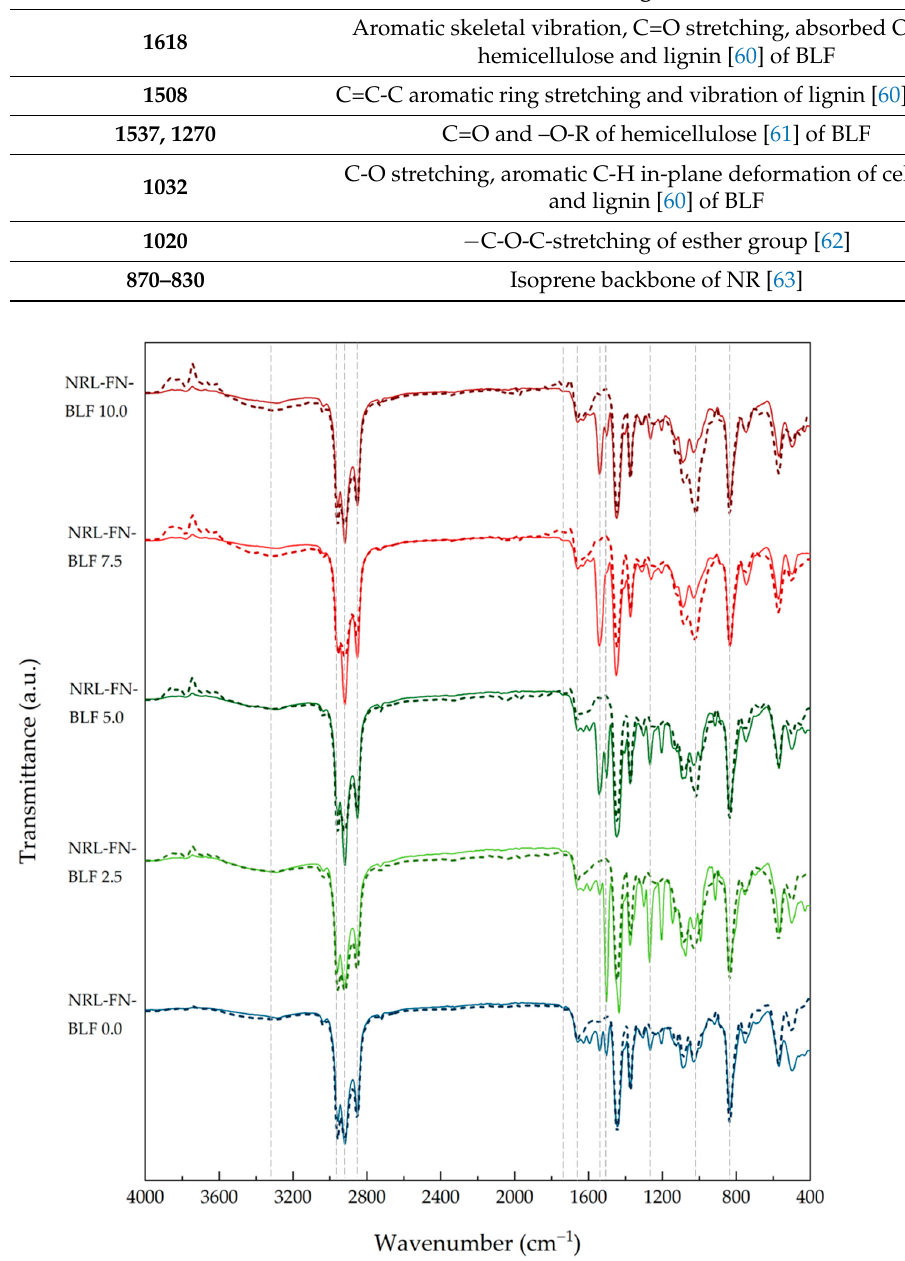
Figure 14. FTIR spectra of NRL foam composites before (solid lines) and after (dash lines) soil burial. FTIR spectra of NRL-FN-BLF0.0 before soil burial showed peaks at 2800–3000 cm − 1 ( − CH stretching), 1655–1665 cm − 1 ( − C=C-stretching), and 835 cm − 1 (=CH bending in isoprene backbone of NR). When compared to NRL foam, NRL foam composites exhibited absorption peaks at 3326 ( − OH stretching vibration of cellulose, hemicellulose, and lignin), 2918 (C-H stretching of cellulose, hemicellulose, and lignin), 1628 (asymmetric stretching band of the carboxyl group of glucuronic acid in hemicellulose, − C=O stretching in conju- gated of a carboxyl group), 1512 ( − C=C-C-aromatic ring stretching and vibration in lignin), and 1033 ( − C-O-stretching of cellulose and lignin) cm − 1 . The absorption peaks of BLF are shown in Figure